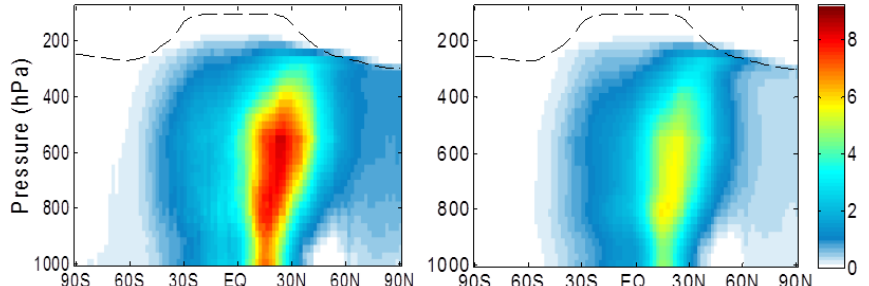
Figure 10. Annual zonal averaged CH 4 loss (10 − 3 1 moleccm − 3 s) induced by aviation NO x emissions. CAM5 is on the left, CAM4 is on the right. The dashed line indicates the